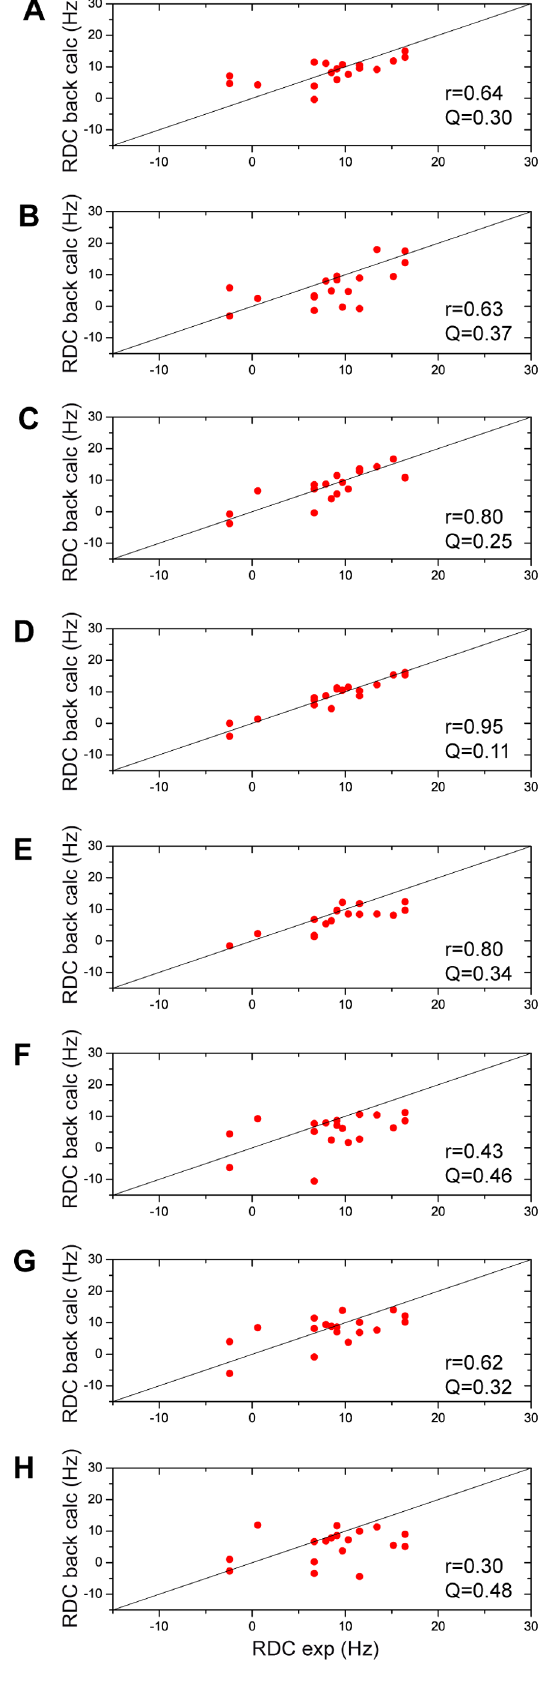
Figure 8. Experimental versus back-calculated RDC for helices a 2 and a 3. Comparison of the experimental RDC measured for the protein-fragment 1 complex and the back-calculated RDC on 8 different PDB structures: (A) 1R2D (B) 1LXL (C) 1YSG (D) 2O2M (E) 2YXJ (F) 1G5J (G) 2PON (H) 1BXL (See Table 1 for more